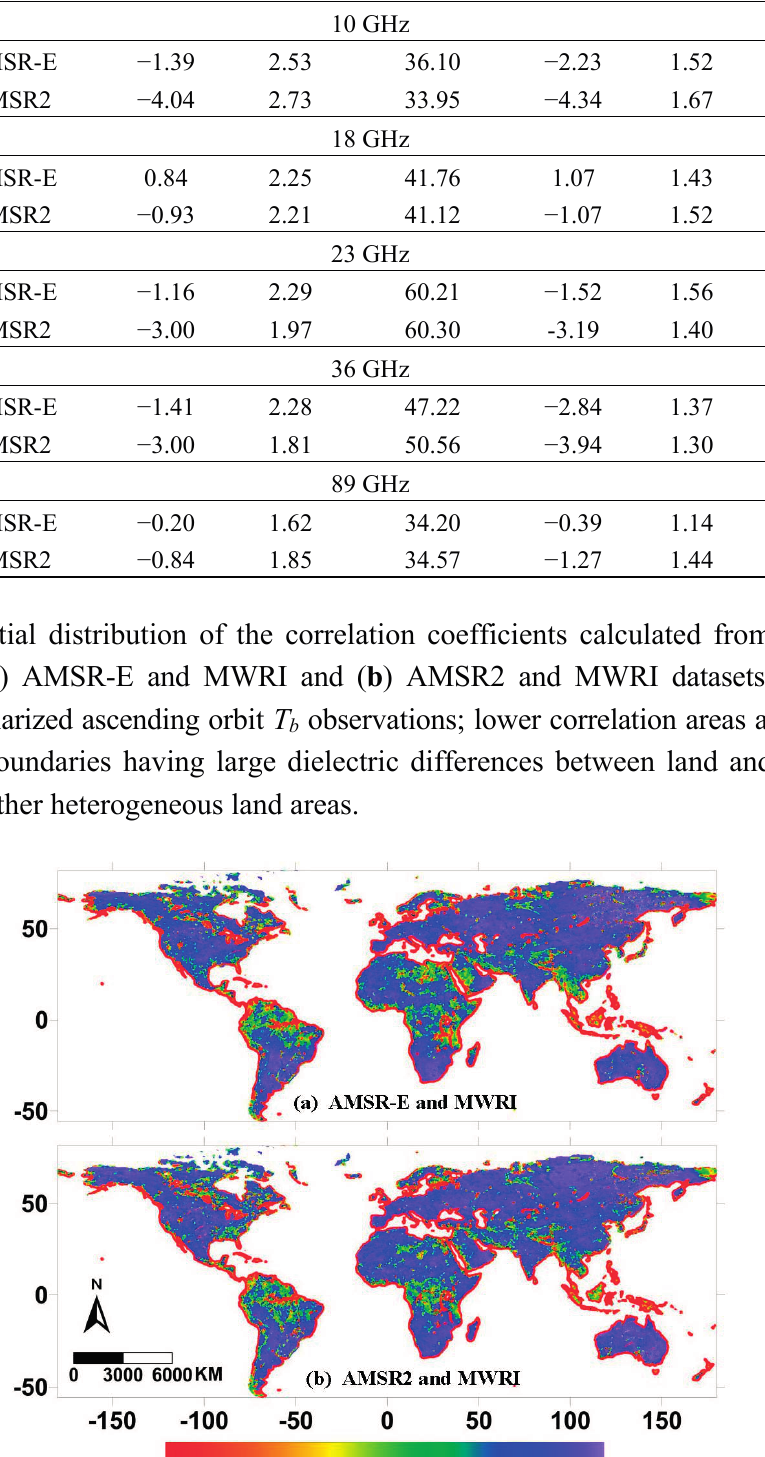
Table 3. Summary of sensor Descending orbit T Deviation (STD) (Unit: Kelvin) values estimated from overlapping AMSR and MWRI records for well correlated ( R > 0.95) pixels, and the percentage of the global land domain with R > 0.95.